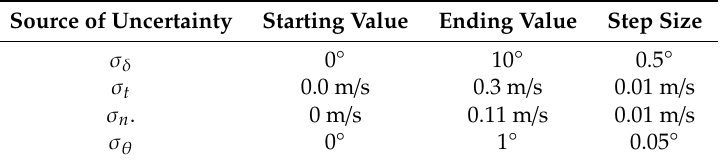
Table 2. Strategy of generating synthetic data